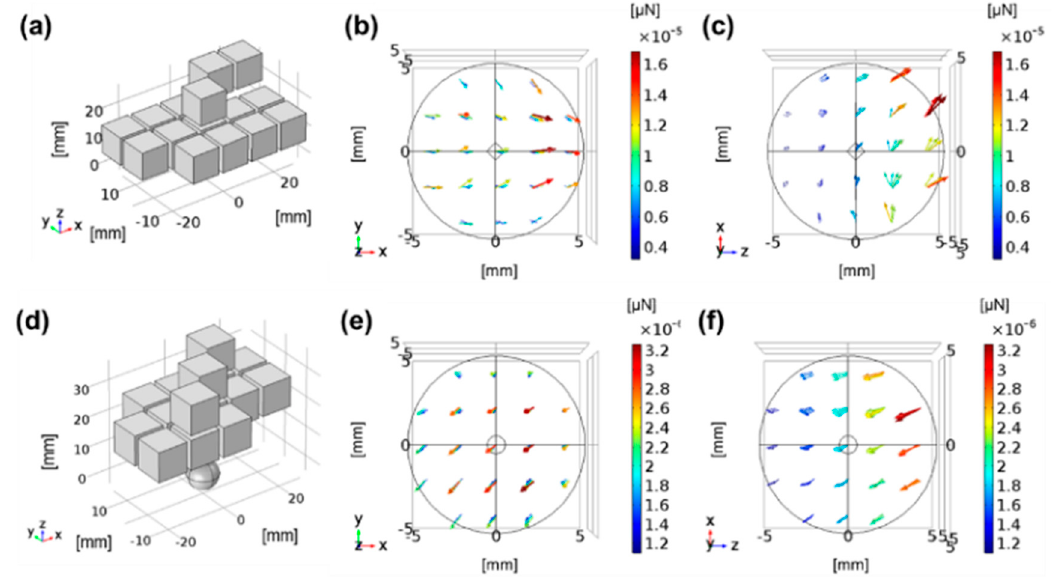
Figure 3. Simulation for a fixation device capable of pulling and pushing. ( a ) An exemplar optimized configuration; ( b ) the resultant magnetic field; and ( c ) the pulling force. ( d ) An exemplar configuration; ( e ) the resultant magnetic field; and ( f ) the pushing force.